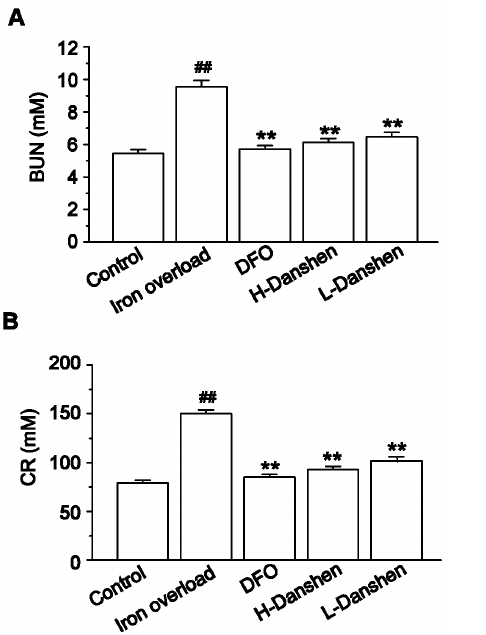
Figure 6. Effects of Danshen injection on serum BUN and CR levels. Serum BUN (A) and CR (B) levels were measured in control, iron overload, DFO, H-Danshen and L-Danshen groups. Data are presented as means 6 S.E.M of 15 animals per group. **P , 0.01, compared with iron overload group; ## P , 0.01, compared with control group.